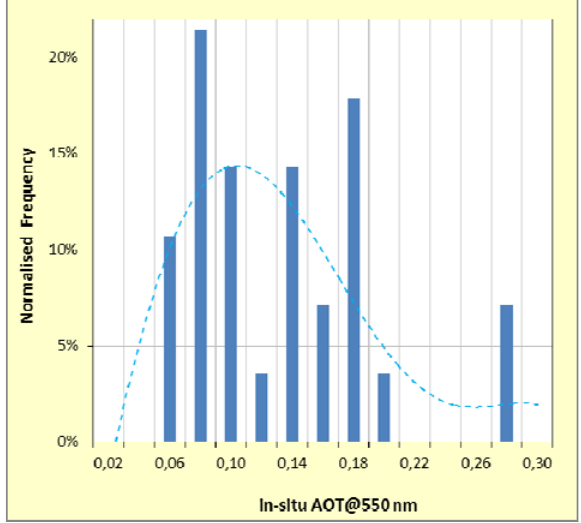
Figure 3. Frequency distribution of in-situ AOT at 550 nm computed from Microtops measurements. The dashed line is a polynomial fit through the